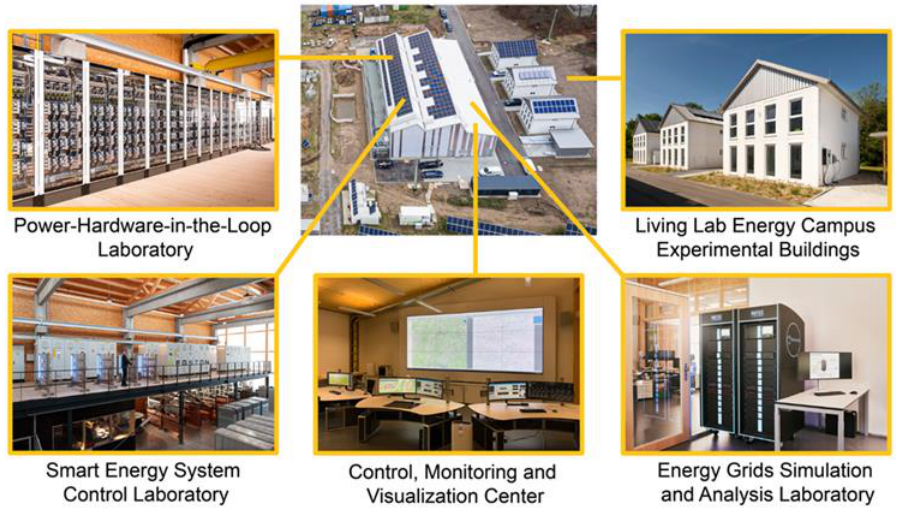
Figure 15. Smart Energy System Simulation and Control Center within the Energy Lab 2.0. Photo: M. Breig (KIT).